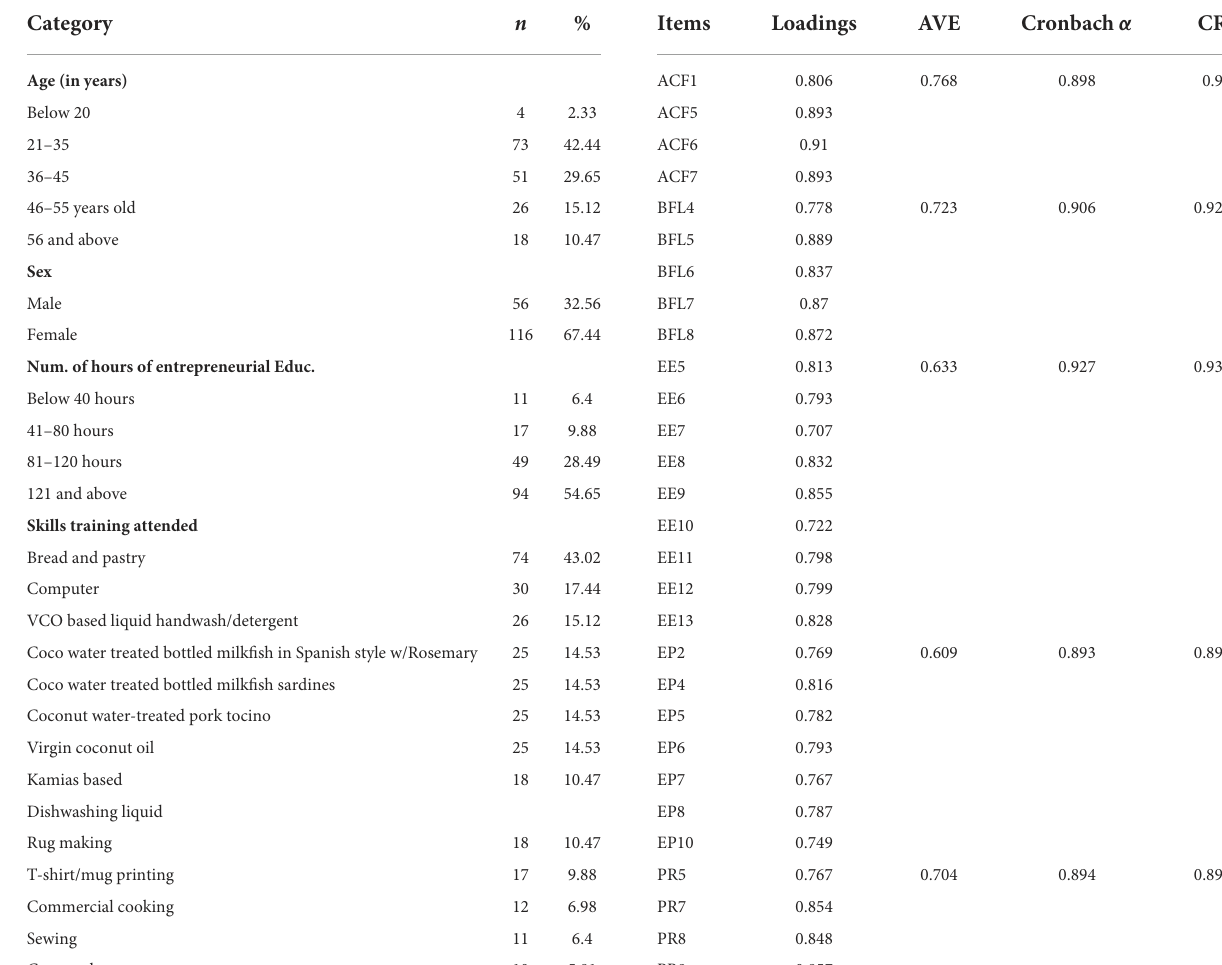
TABLE 1 Profile of the respondents. TABLE 2 Measurement model assessment